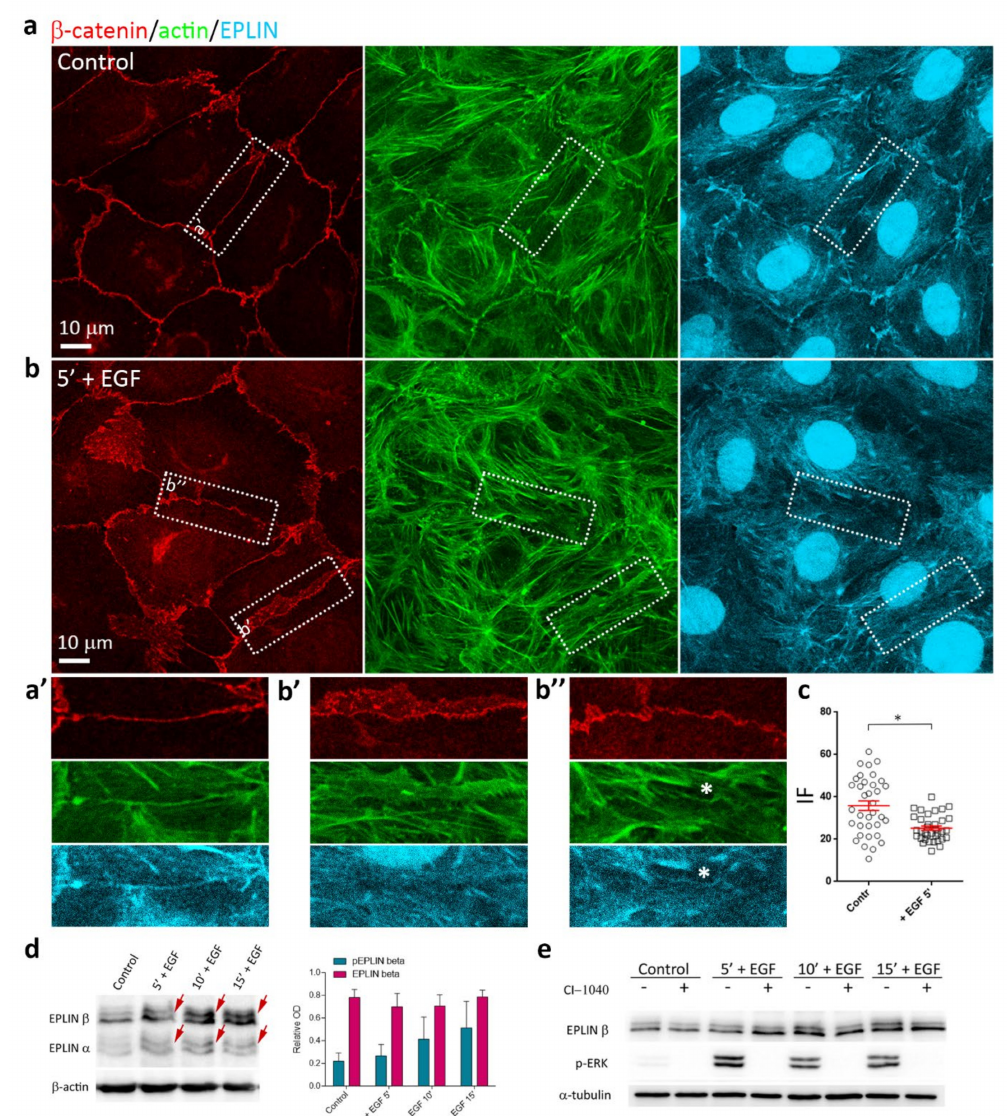
Figure 8. E ff ects of EGF on EPLIN in IAR-20 cells. ( a ), (a’) In control IAR-20 cells, EPLIN colocalizes with the circumferential actin bundles at cell-cell boundaries. ( b ) Addition of EGF leads to release of EPLIN from the zones of disorganization or disappearance of the circumferential bundles (Figure 8b’,b”). EPLIN colocalizes with the remaining intact circumferential bundle (Figure 8b”, asterisk). ( c ) EPLIN fluorescence intensity at the cell-cell boundaries in control and EGF-treated cells. Circles and squares represent individual cells, N = 35, * p < 0.001. ( d ) Western blot analysis of EPLIN phosphorylation (5% PAAG). Arrows indicate up-shifted bands of phosphorylated EPLIN in the cells treated with EGF. β -actin was used as loading control. Densitometry results are averaged across three independent experiments. Data are presented as mean ± SEM. ( e ) MEK inhibitor CI-1040 (4 µ M), which inhibits phosphorylation of ERK (p-ERK), significantly decreases the levels of phosphorylated EPLIN at 10 min and 15 min after the addition of EGF. α -tubulin was used as a loading